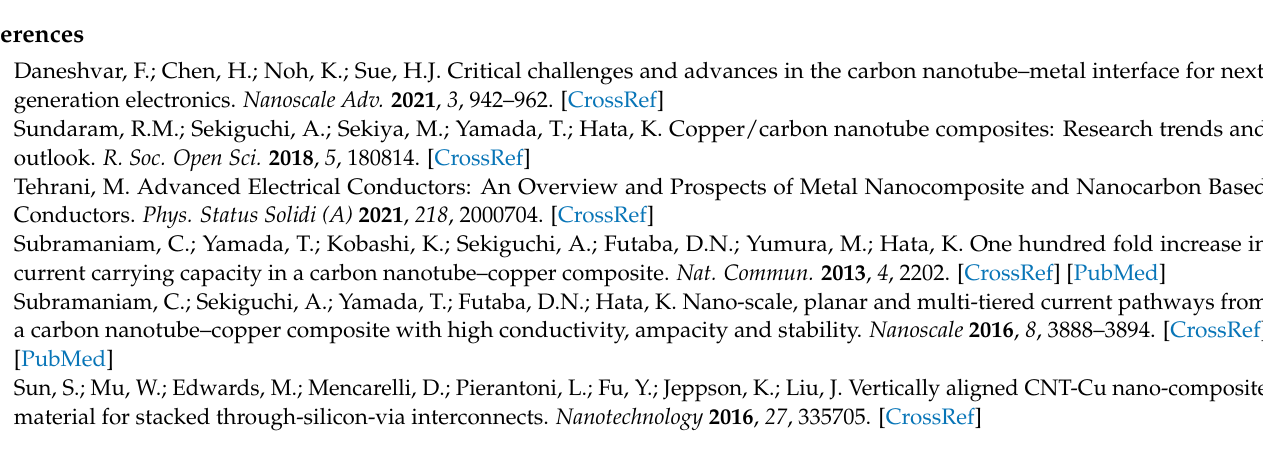
Figure S4: Raman spectra and SEM images of SW-CNTP before and after carbon coating, Figure S5: SEM images of SW-CNT/Cu pillars (array and individual pillar), Figure S6: Cross-section SEM images of the Cu-seeded MW-CNTW, SW-CNTW, and SW-CNTP samples after organic Cu electrodeposition and H 2 reduction, Figure S7: Measured resistance normalized by room-temperature resistance, R/R 298 vs. difference between measurement temperature and room temperature, T-T 298 , Table S1: Cu content (wt %) in and cross-section areas of CNT/Cu composites, Table S2: Conductivity and TCR of CNT templates used for CNT/Cu